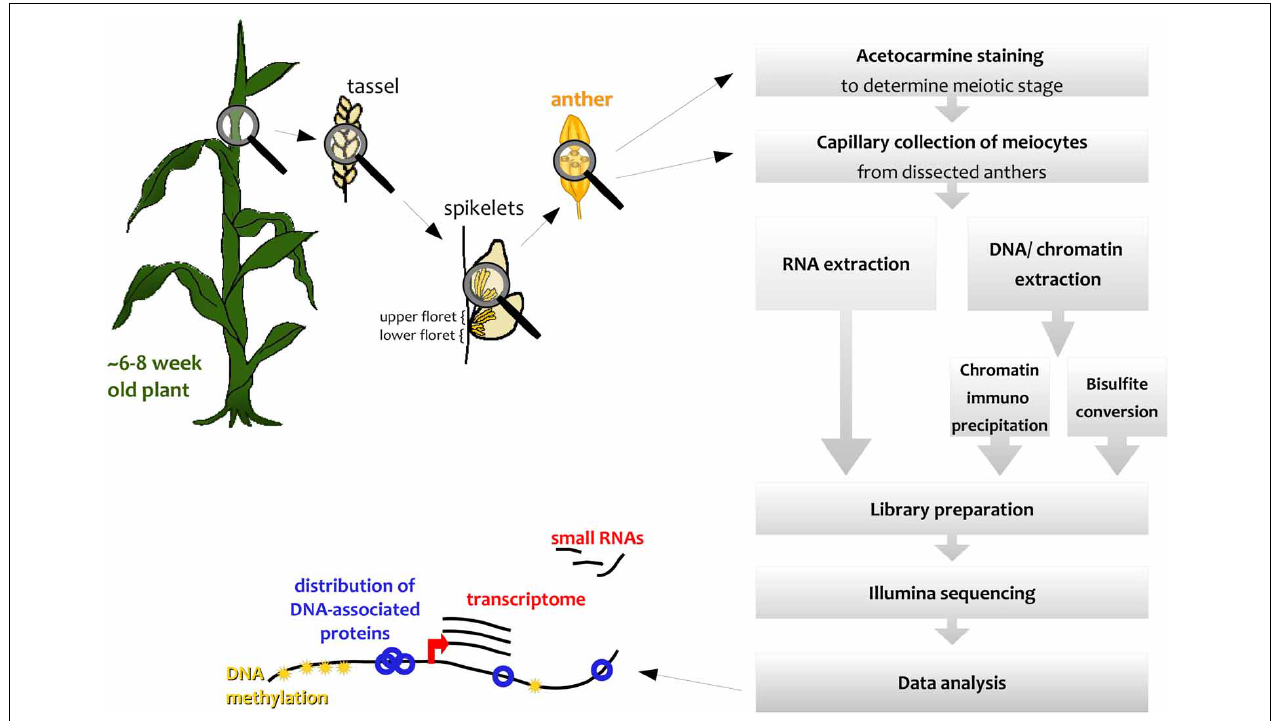
FIGURE 1 | Simplified workflow